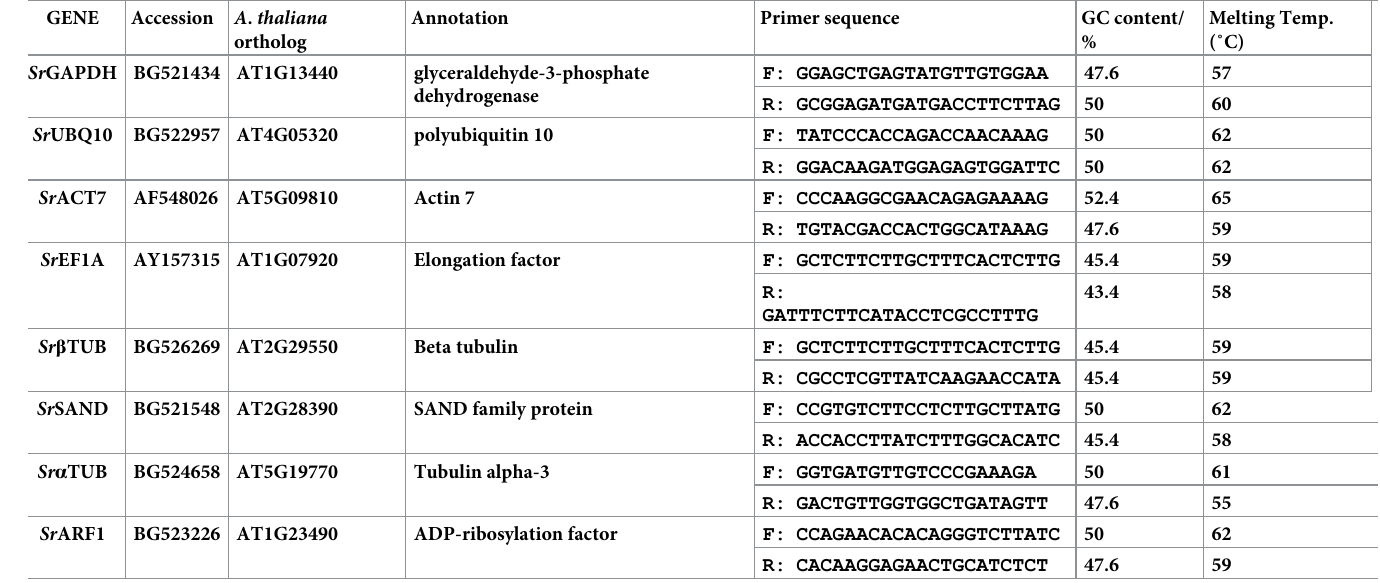
Table 3. Primer sequences of eight reference genes along with their accession numbers and A . thaliana orthologs. GENE Accession A . thaliana